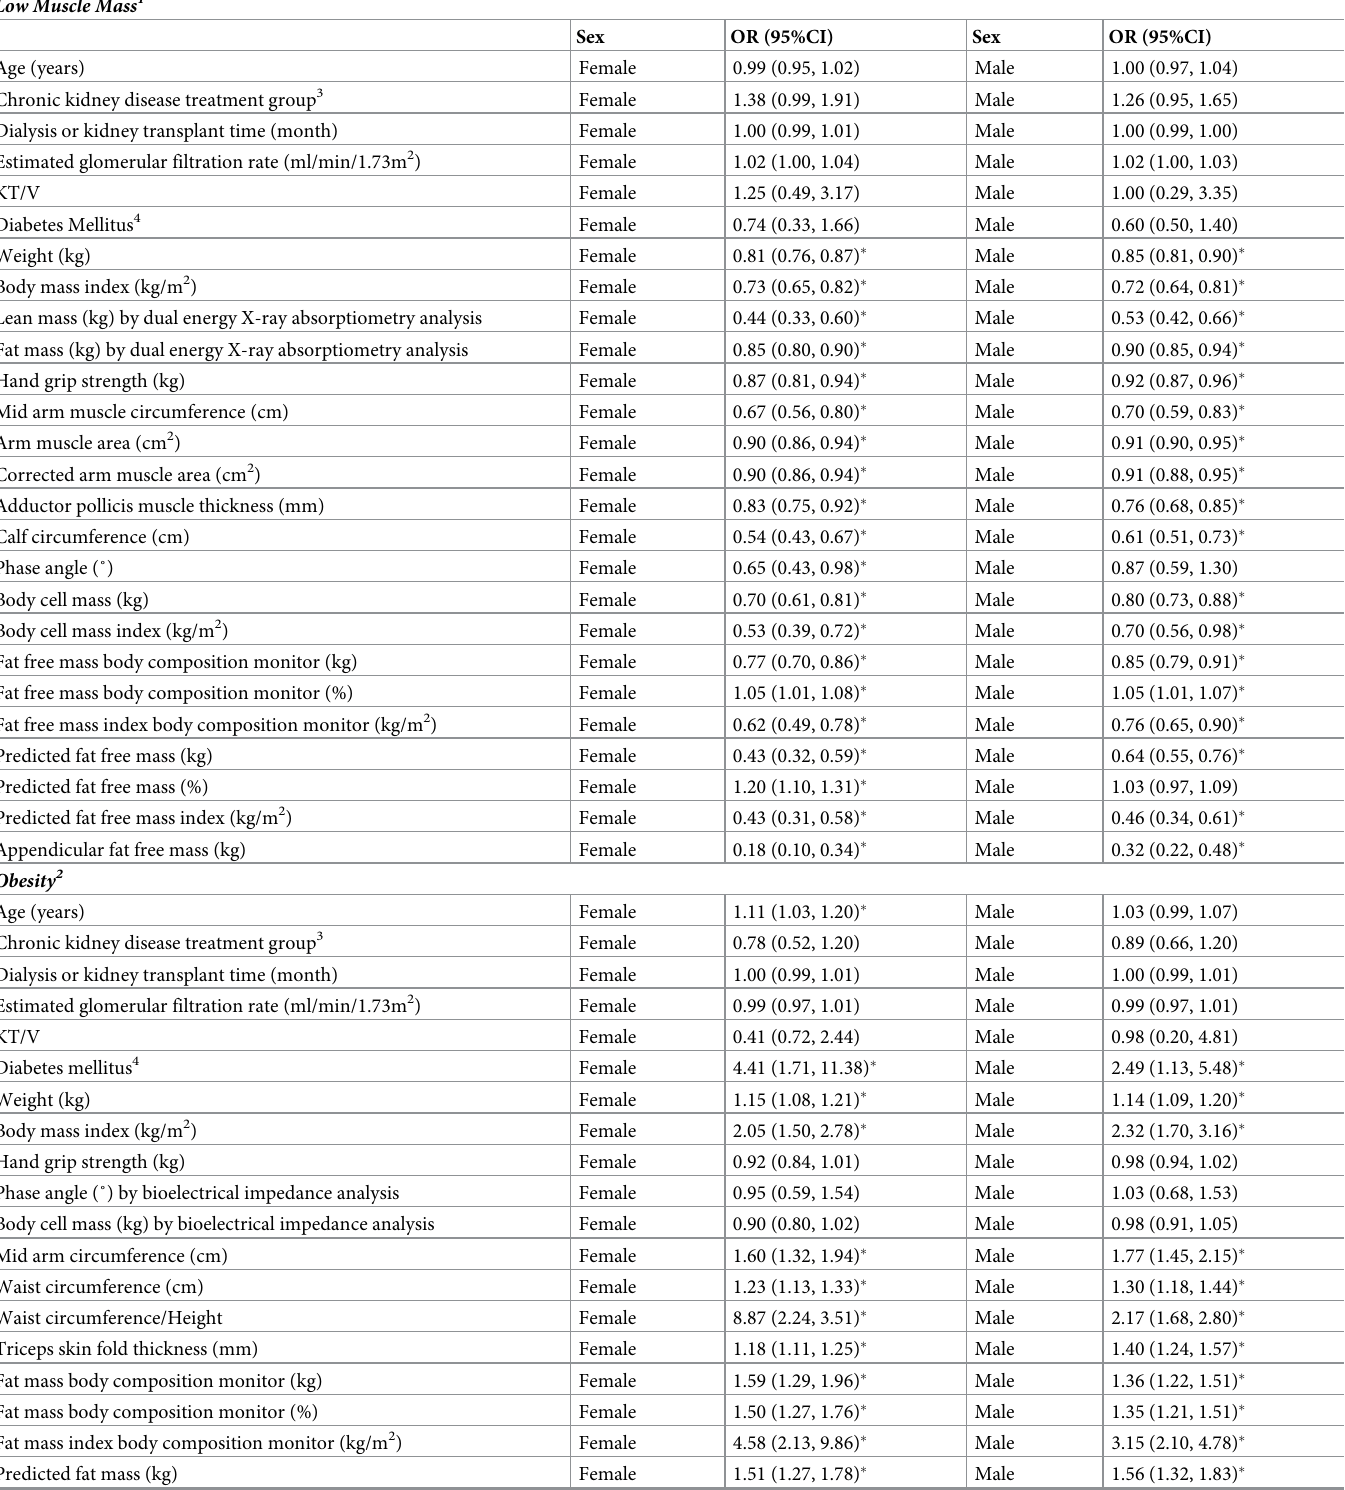
Table 2. ORs of the clinical, muscle, adiposity and bioelectrical data for low muscle mass 1 and obesity 2